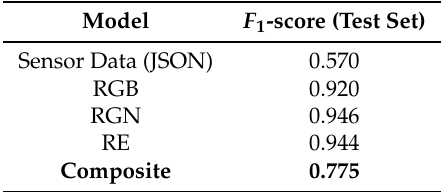
Table 5. F 1 -score reached by the individual submodels and the composite model.